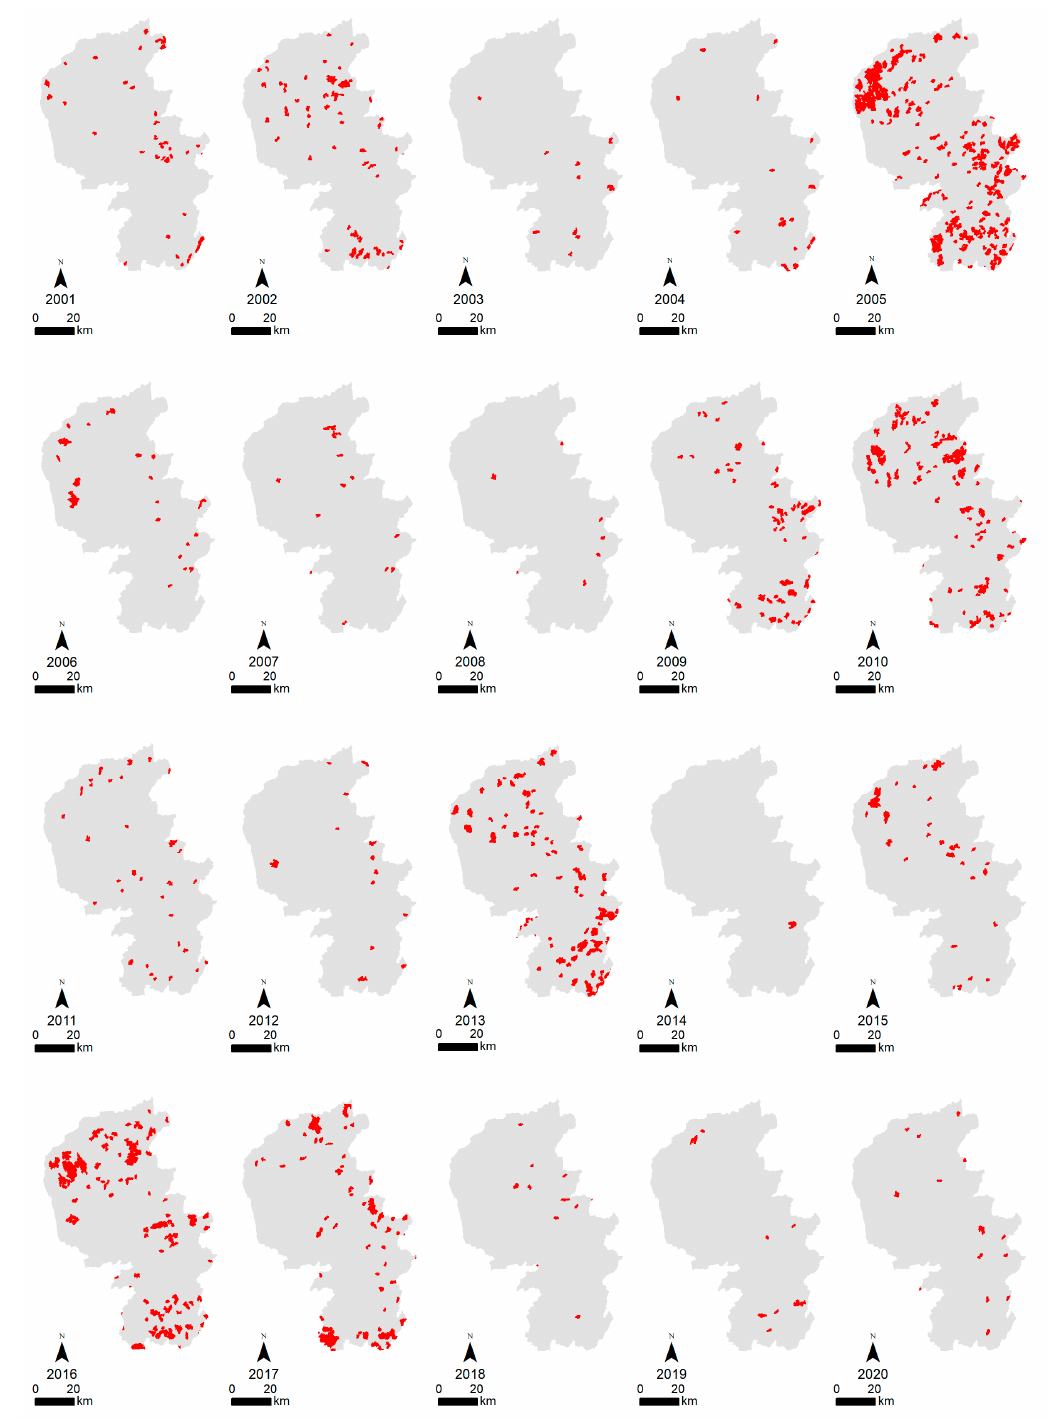
Figure 8. Annual distribution of the burnt area in northwestern Portugal from 2001 to 2021. The territory referring to the northwestern Portugal region is in grey, and the burnt areas per year are in red. Table 6. Number and burnt area of LW ( ≥ 100ha) in Portugal mainland.